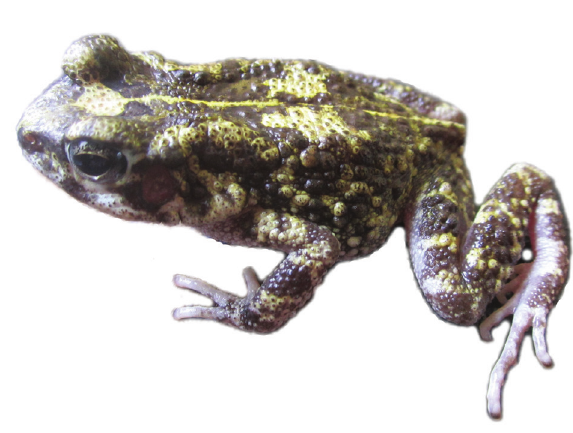
Figure 3. Sites around Idanre Hills surveyed for Amietophrynus perreti ; green circles: toads recorded, red crosses: toads not found.